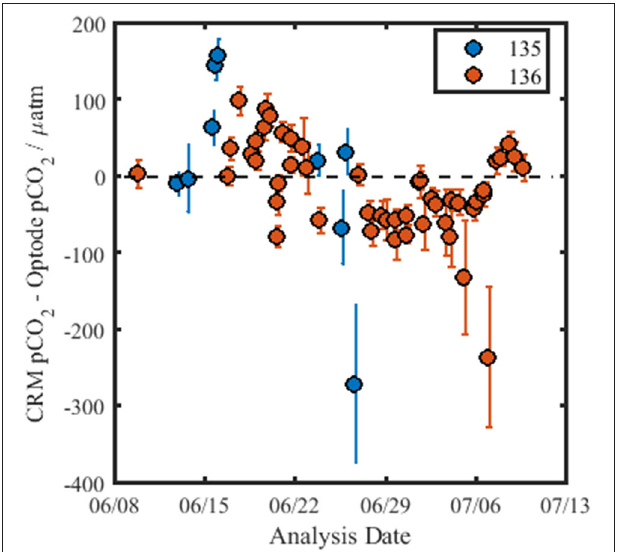
FIGURE 6 | Residuals for pCO 2 for the CRM measurements using the optode, over the course of the cruise. The black dashed line indicates no difference between the calculated pCO 2 -value of the CRM (pCO 2 - calcTA ) and the pCO 2 -value obtained using the optode. The color of the data points denotes the CRM batch measured, and the error bars are calculated as the standard deviation of the repeat measurements of each CRM bottle ( n ≥